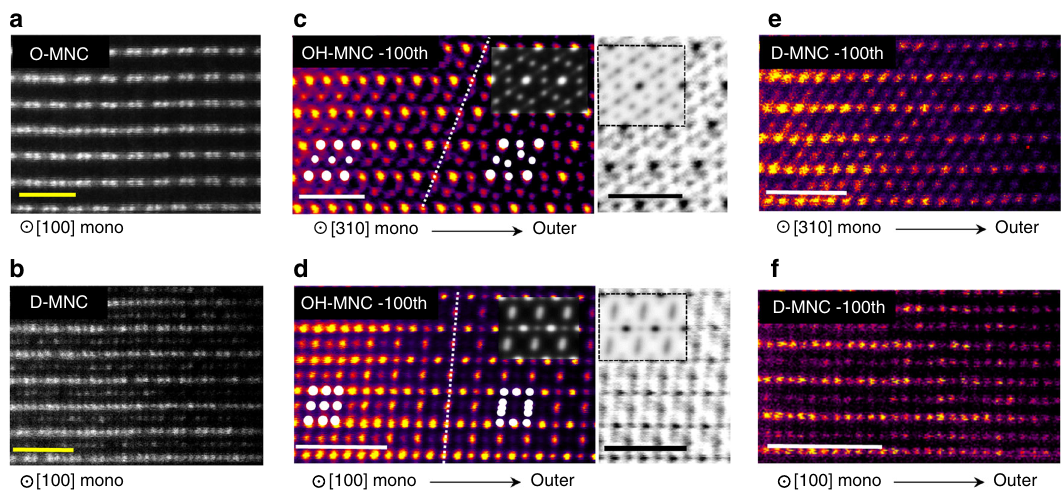
Fig. 4 Evolution of atomic structure. HAADF-STEM image of the a [100] mono Pristine O-MNC, b [100] mono Pristine D-MNC particle. c [310] mono OH-MNC, d [100] mono OH-MNC, e [310] mono D-MNC and f [100] mono D-MNC particle (discharged state) after 100 charge-discharge cycles. Enlarged HAADF/ABF- STEM images of the surface region in images c and d with simulate HAADF/ABF-STEM images (in the inset) are presented; Scale bar denotes 1